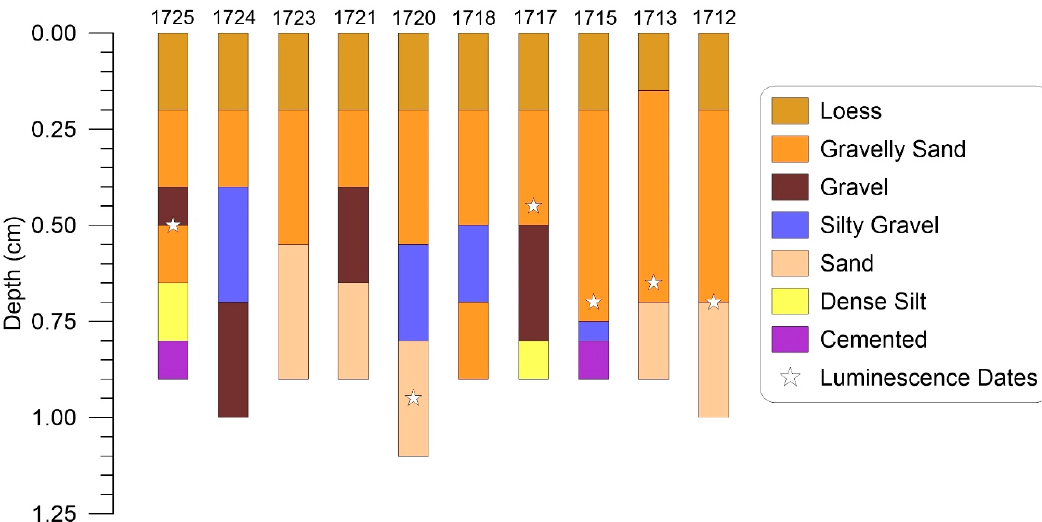
Figure 9. Example exposure excavated into the crest of the shoreline built when Lake Clover stood at 1718 m. The layer of gravel-poor silt, roughly corresponding to the Av horizon, at the top of the exposure is clearly evident. Layers of imbricated gravelly sand are present below this surficial layer. A sand-dominated layer is also obvious near the bottom of the exposure.